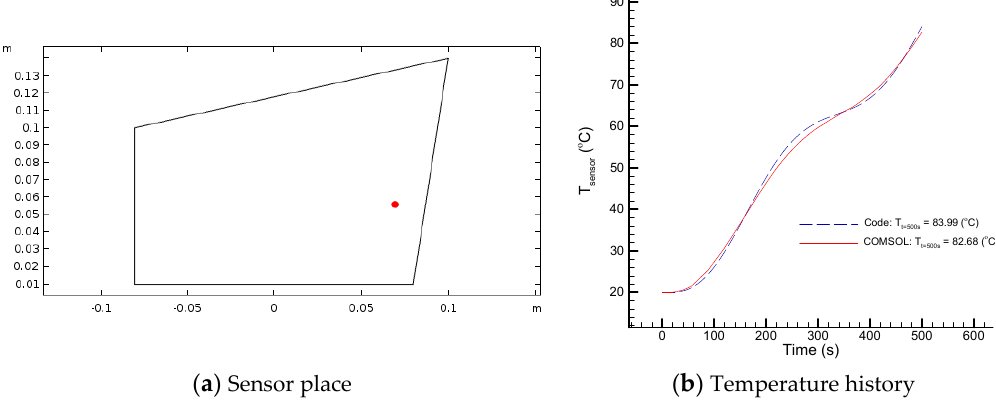
Figure 4. Comparison of temperature history at the sensor place, S ( 3,12 ) , obtained from the explicit solver and the finite-element software COMSOL.